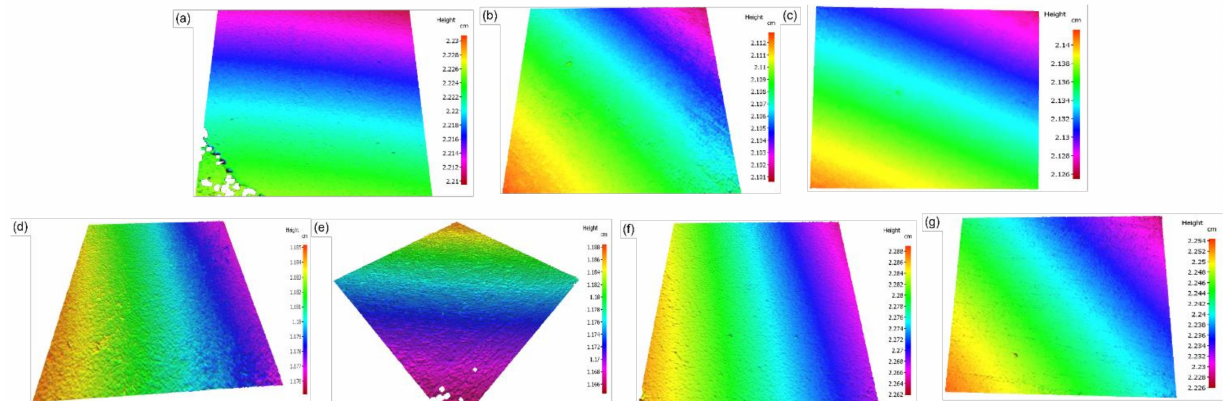
Figure 12. IFM microscopies of thermomechanically treated samples after testing in FA pore solution containing 0.6 M NaCl ( × 5): ( a ) As received, ( b ) Annealing, ( c ) Normalizing, ( d ) Water quenching, ( e ) Oil quenching, ( f ) subcritical annealing after water quenching, and ( g ) subcritical annealing after oil